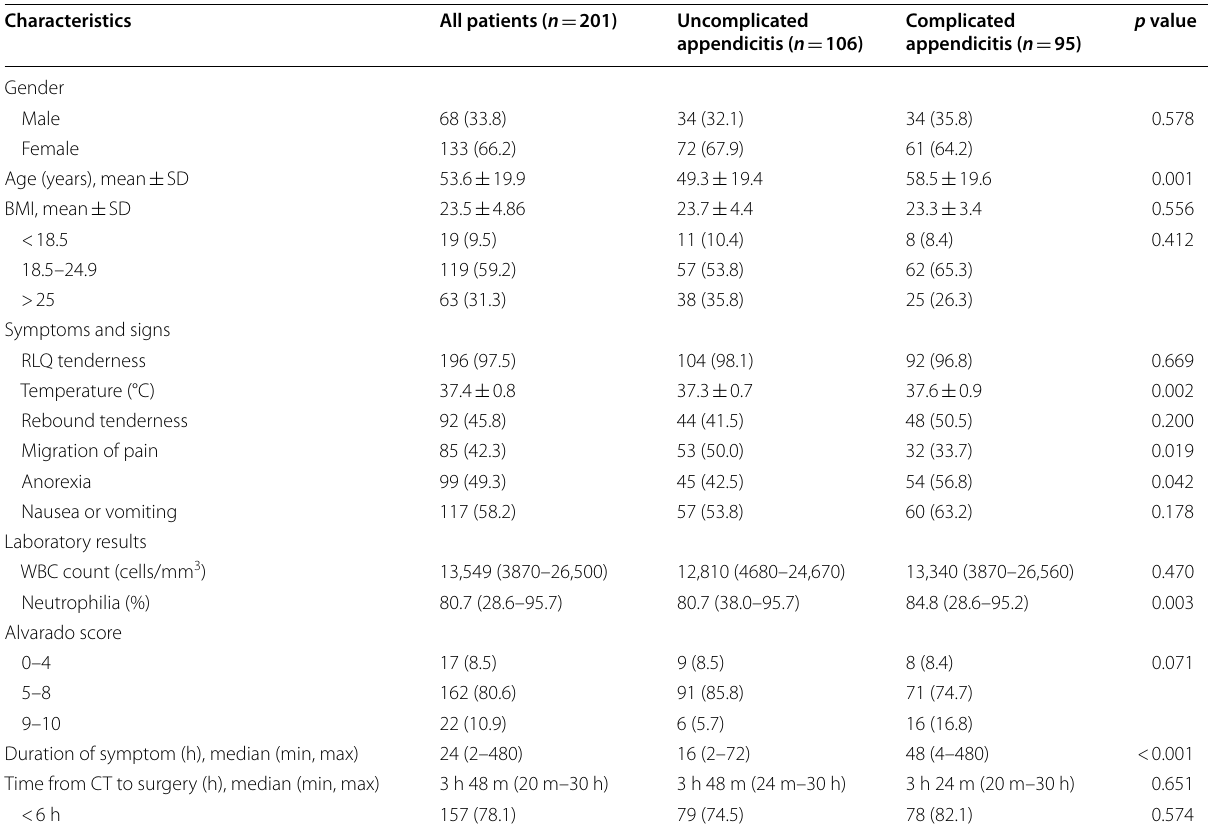
Table 2 Patient